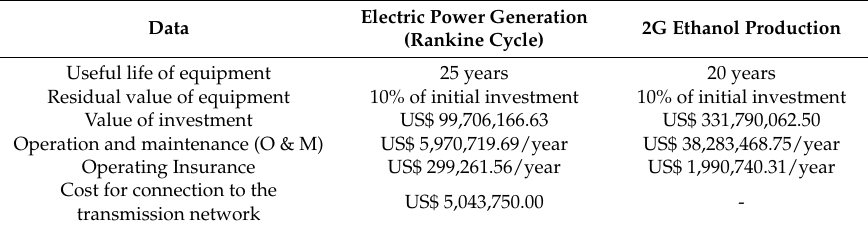
Table 2. Data used for financial